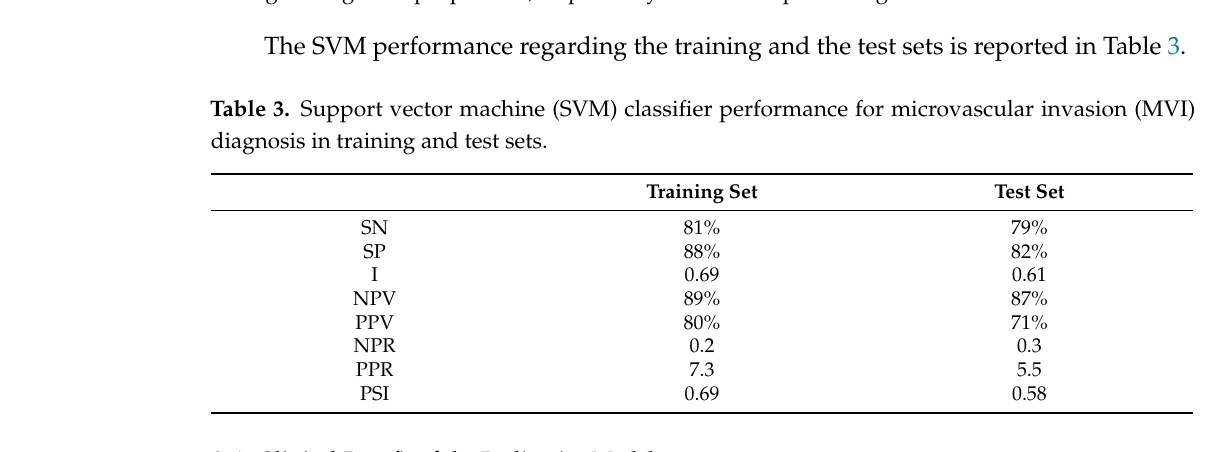
Figure 9. Waterfall plots for training ( a ) and test ( b ) sets. MVI+ and MVI − samples are represented through orange and purple bars, respectively with zero representing the cut-off.